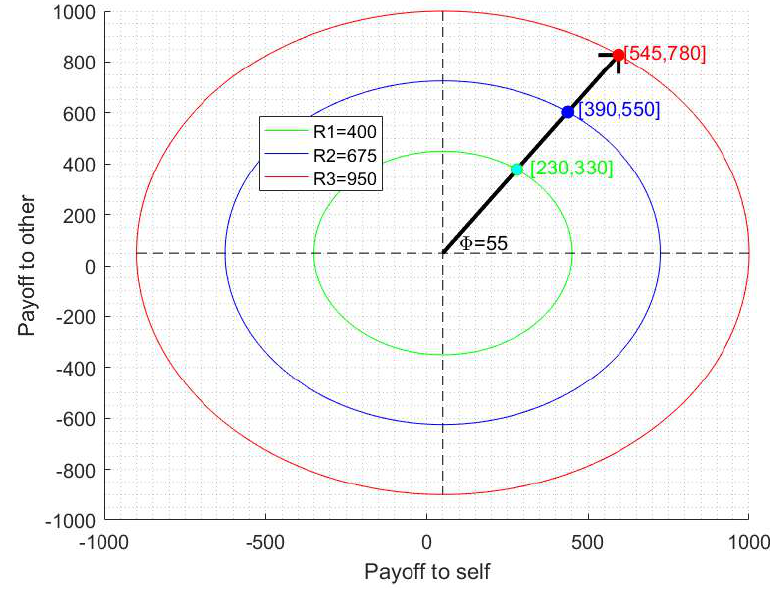
Figure 1. The SVO slider method parameters—radius and angle.